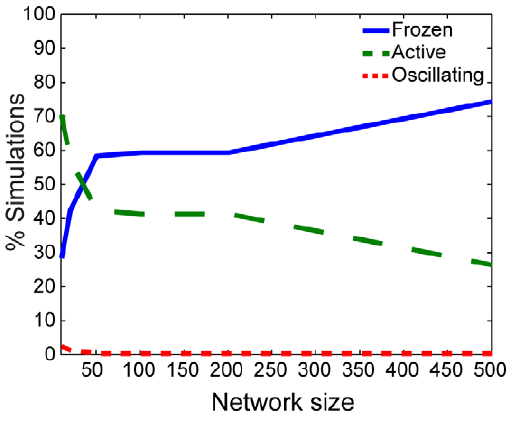
Figure 4. Dependence on network size for qualitative states for k h , x ~ 1 and s v ~ 10 . Percentage of simulations with qualitative dynamics plotted as described in Figure